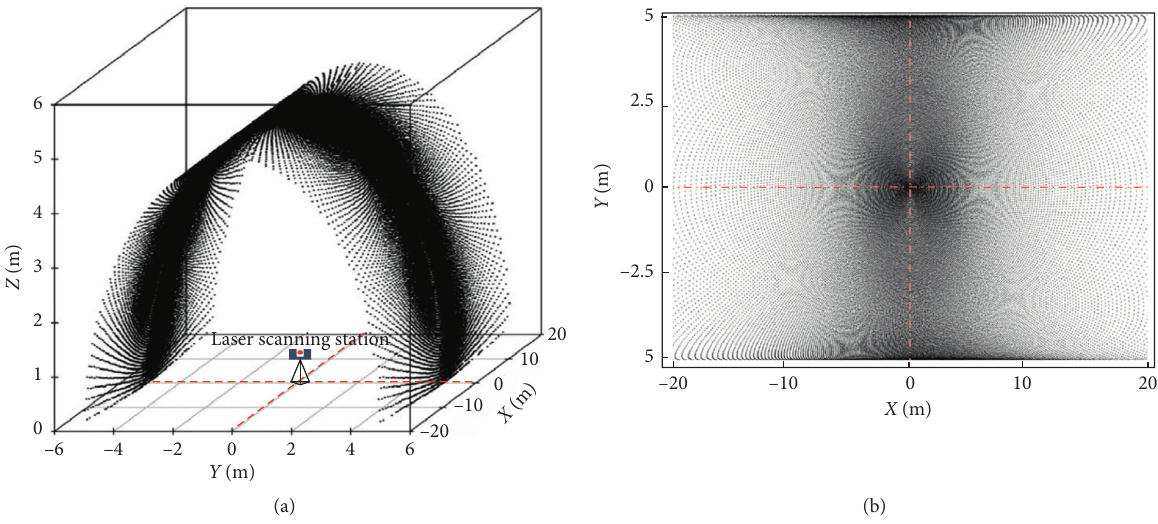
Figure 8: Laser scanning point cloud distribution. (a) Three-dimensional view. (b) Expanded view.